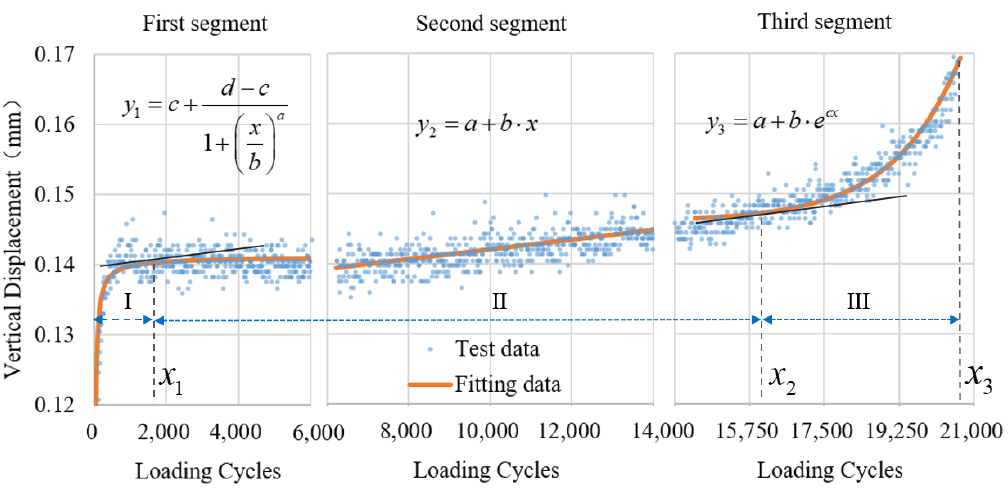
Figure 6. Three-stage fitting method for distinguishing fatigue cracking stages of ECC. Table 1. Regression fitting parameters of three-stage